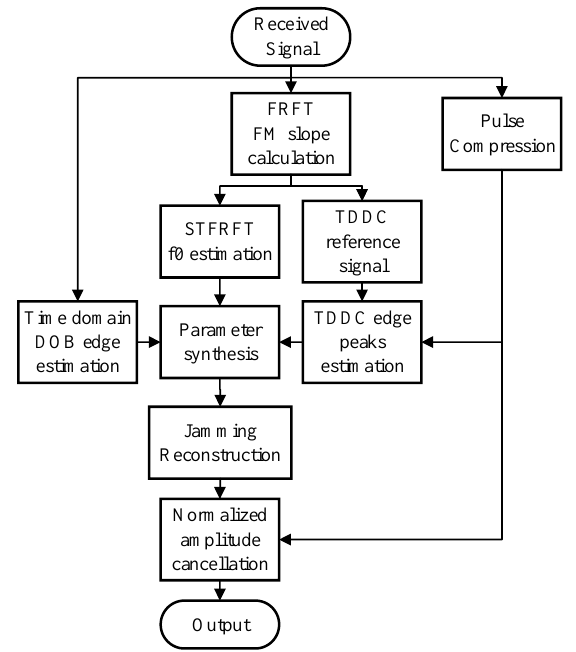
Figure 3. Block diagram of the proposed method.